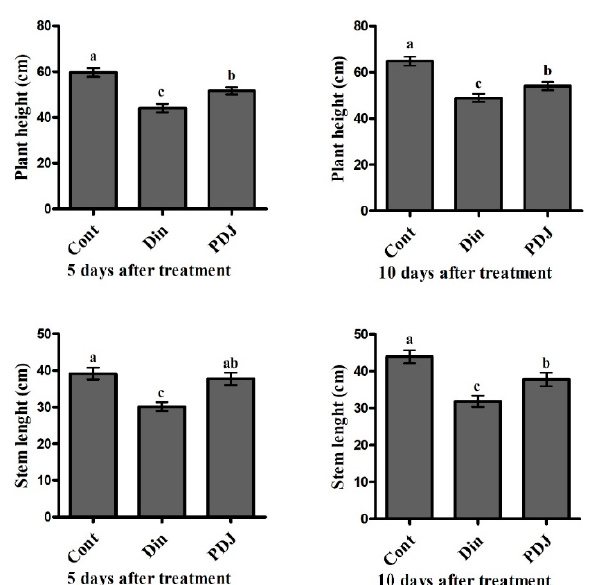
Fig. 1: Effects of different treatments on the inhibition of plant height and stem length per each treatment 60 and 90 days after sowing (Cont; Control, Din; Diniconazole, PDJ; Prohydrojasmon). The differences between the mean values were determined using a Duncan’s mul- tiple range test (DMRT) at P < 0.05. The results were graphically presented using GraphPad Prism (version 5.0, San Diego, CA, USA). The SAS 9.1 was used for DMRT